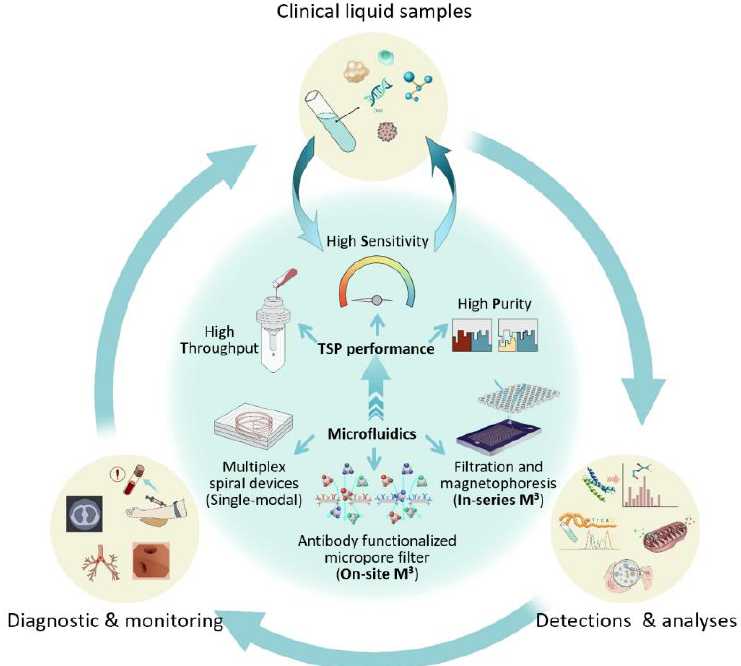
Figure 2. Schematic illustration of clinical practices of liquid biopsy, including the TSP performance criteria and the potential microfluidic-based strategies [10,12,14,16,34,35,38]. All the images/icons displayed here were drawn and are fully copyrighted by authors.